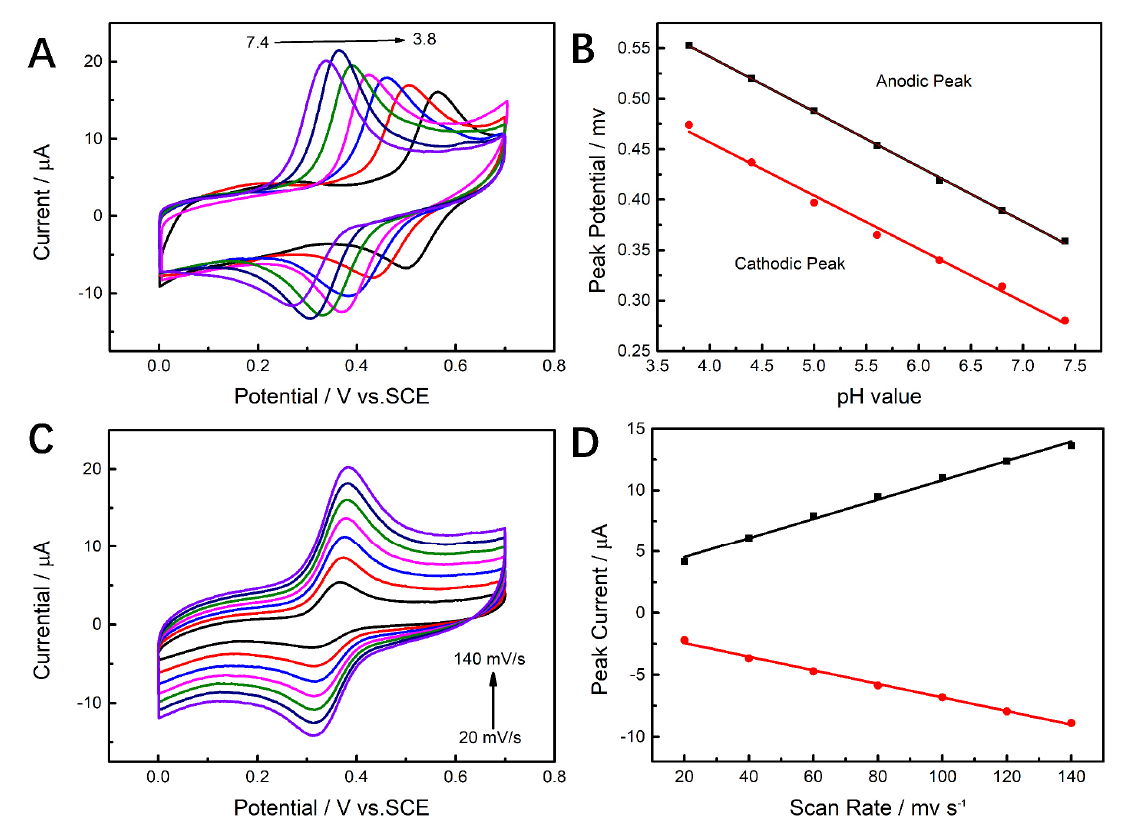
Figure 5. CVs of Fe–NC–800/GCE in 0.1 mol/L CPB with 50 µ M AC (scan rate 100 mV/s) of different pH ( A ); effect of pH value on the oxidation peak potential ( B ); CV of Fe–NC–800/GCE in 0.1 mol/L CPB (pH = 6.8) with 50 µ M AC at different scan rates (20–140 mV/s) ( C ); the linear dependence plot of scan rate on peak currents ( D ), the black line represents the oxidation peak current and the red line represents the reduction peak current.